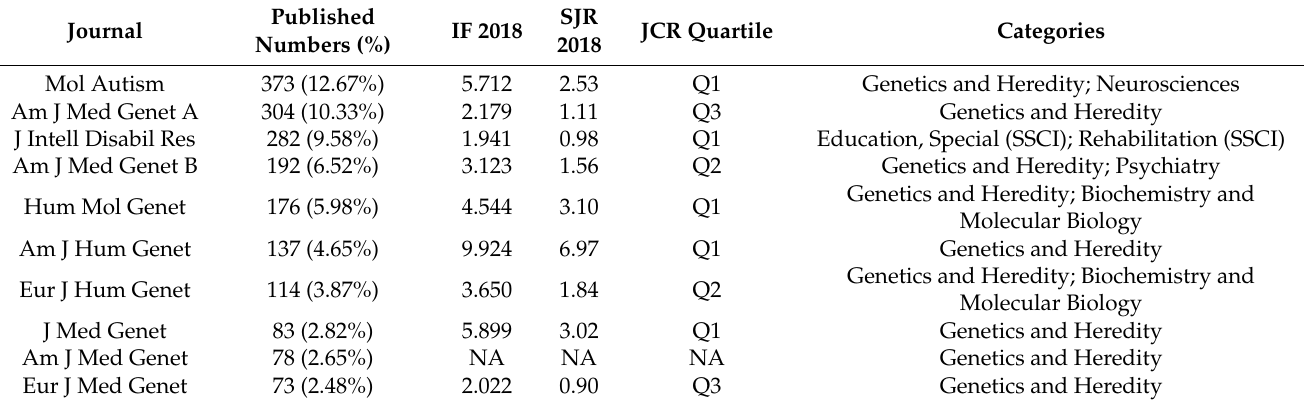
(Table 3), they were all published in two top-notch journals: Nature Genetics and the American Journal of Human Genetics , which both had a relatively high impact factor compared with other scientific journals in the field. Interestingly, all top 10 highly cited articles came from the United States, which was consistent with its contribution in the field. Table 2. The 10 most active journals that published articles on autism genetics research. SJR: SCImago Journal Rank.